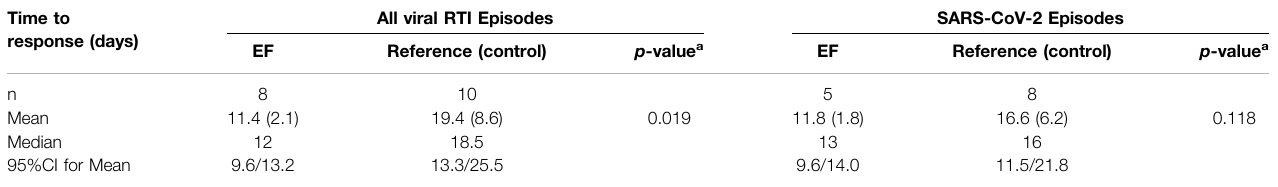
TABLE 4 | Time-to-virus clearance (qPCR negative) during treated (EF) and untreated (control) viral symptomatic RTI episodes. Time to response